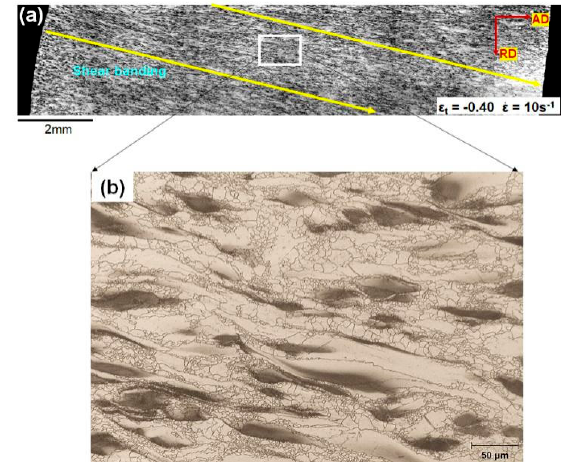
Figure 3. Optical micrographs of macro-SBs at ε t of − 0.40 under the high-strain-rate condition: ( a ) overall microstructure at a lower magnification, ( b ) microstructure in the framed region of ( a ) at a higher magnification.